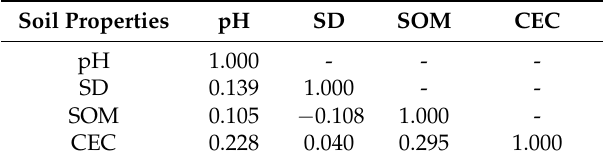
Table 4. Pearson’s correlation coefficients (R) between soil properties for tested soil properties. Soil Properties pH SD SOM CEC pH 1.000 - - - SD 0.139 1.000 - - SOM 0.105 − 0.108 1.000 - CEC 0.228 0.040 0.295